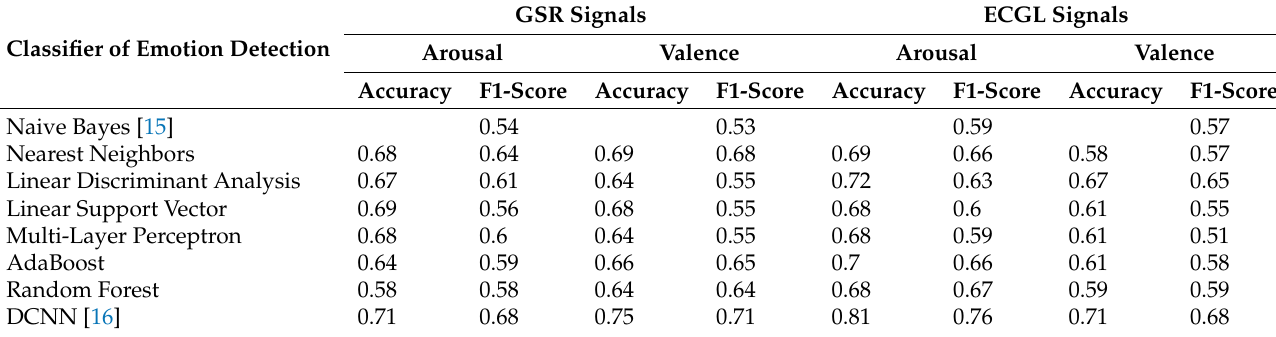
Table 1. Performance of DCNN and shallow ML algorithms using AMIGOS dataset